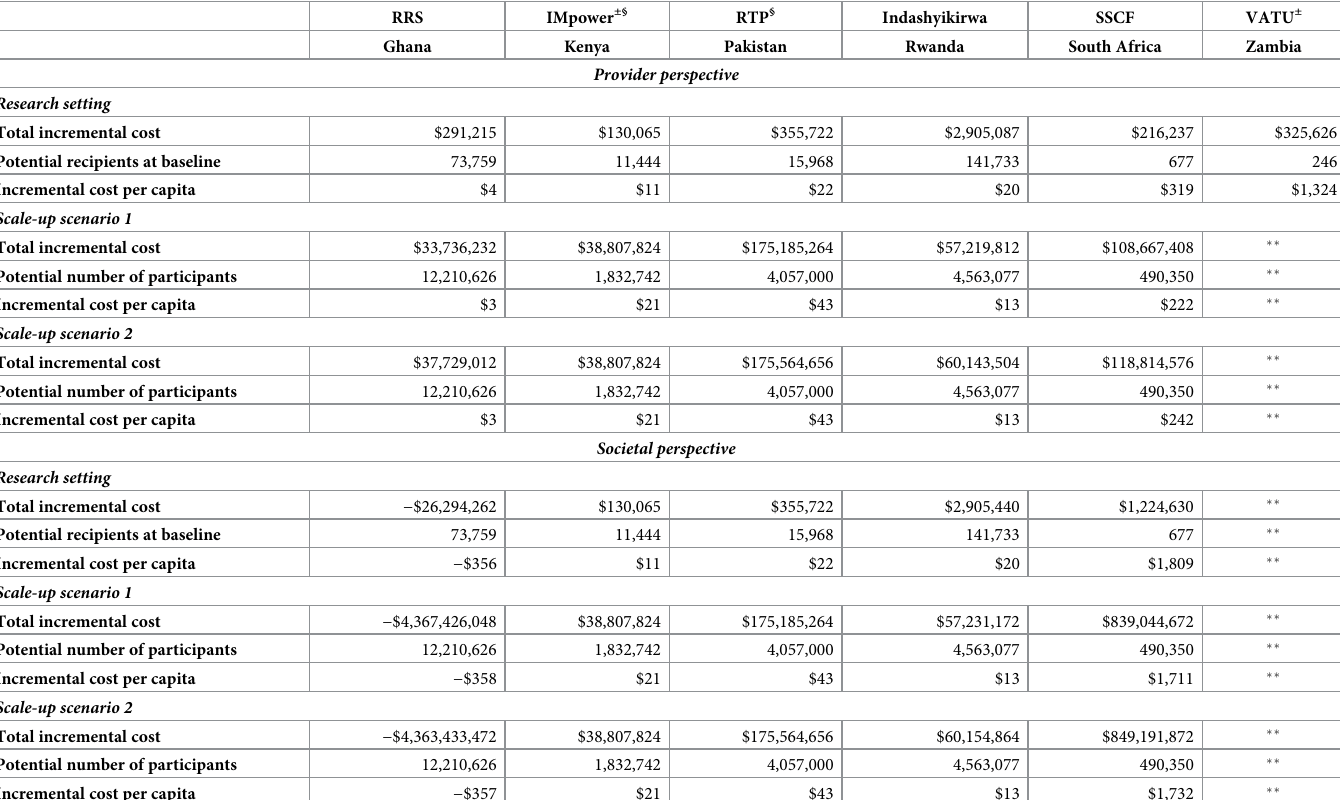
Table 3 presents the summary costs for each intervention. Provider costs per participant range from $3.95 for the community intervention in Ghana to $1,324 for one-on-one counsel- ling in Zambia in the implementation in a research setting. Table 3. Annuitised intervention costs ± (2018